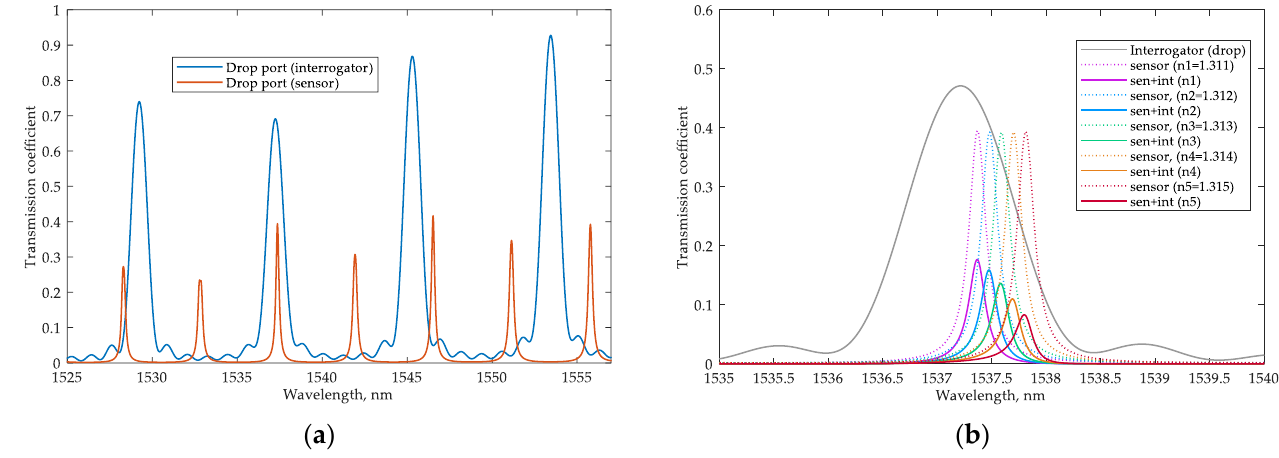
Figure 8. ( a ) Transmission spectra at the drop ports of the sensor and interrogator MRRs; ( b ) Wavelength dependence of the system transmission coefficient for the different analyte RIs.